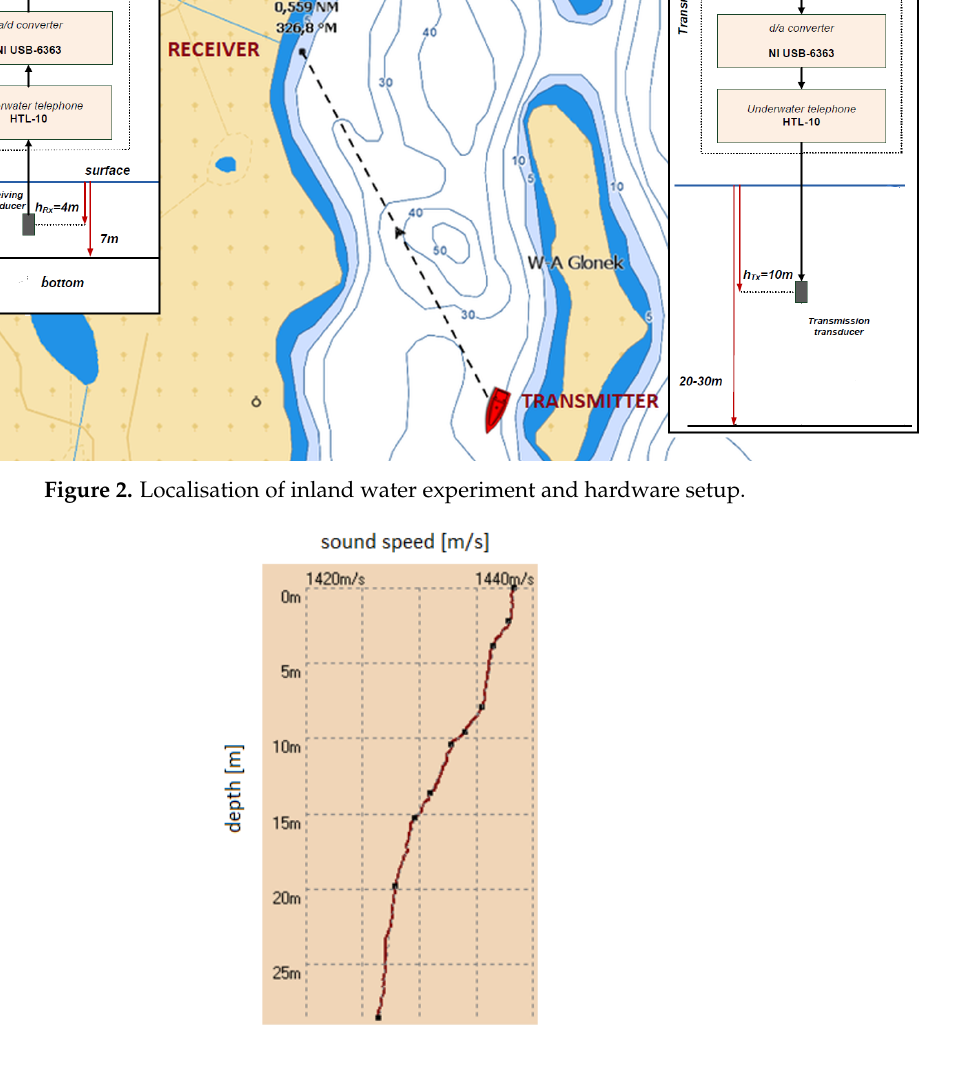
Figure 3. Sound speed profile measured during inland water